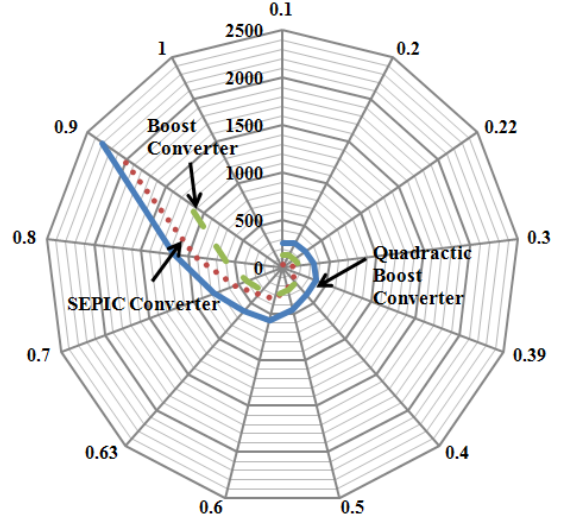
Figure 15. Voltage waveform of Boost, SEPIC and Quadractic boost converters (radar plot).